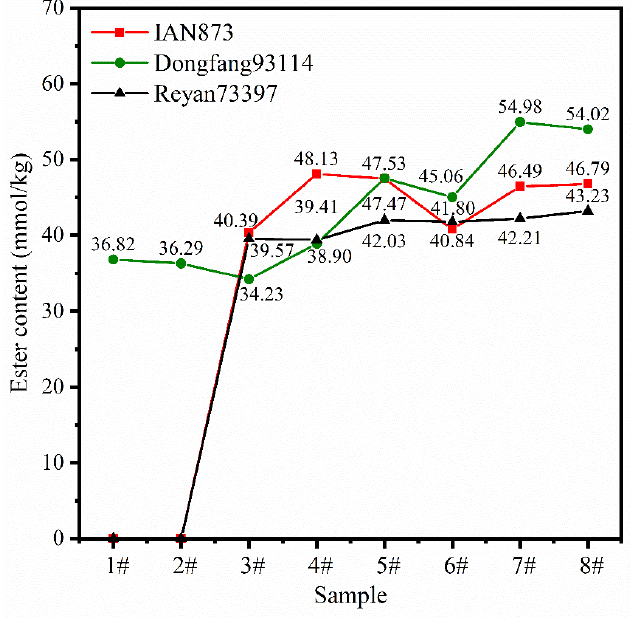
Figure 8. Ester content of rubber obtained from separated latexes of different Hevea brasiliensis clones.